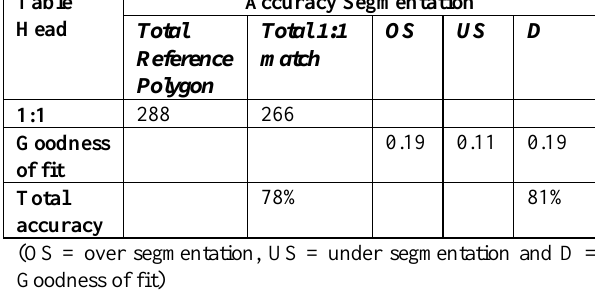
Table 5. Accuracy assessment of OBIA output